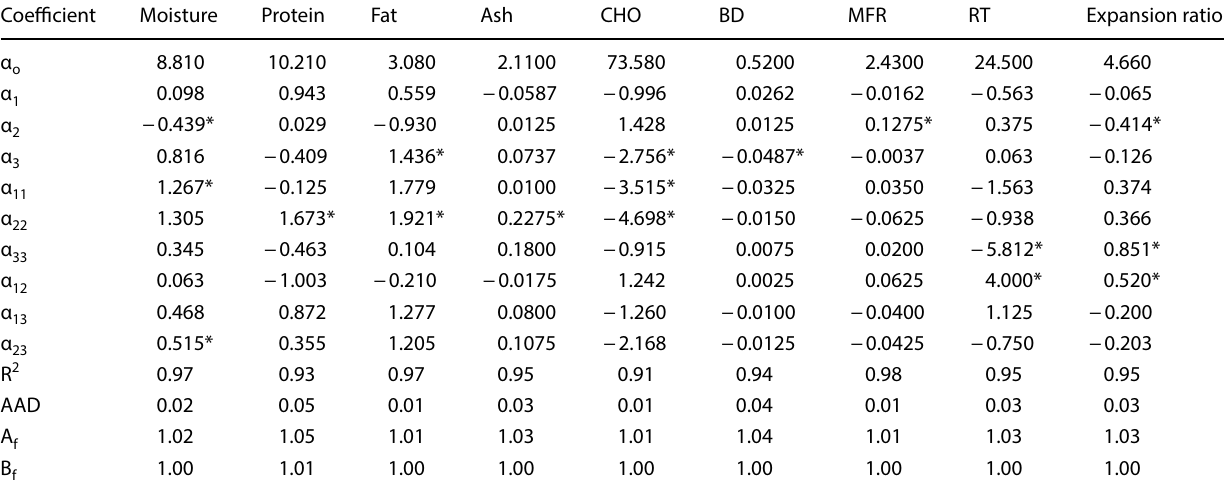
Table 5 Coefficient of regression, R 2 , AAD, Af, and Bf values for the mathematical models of the responses